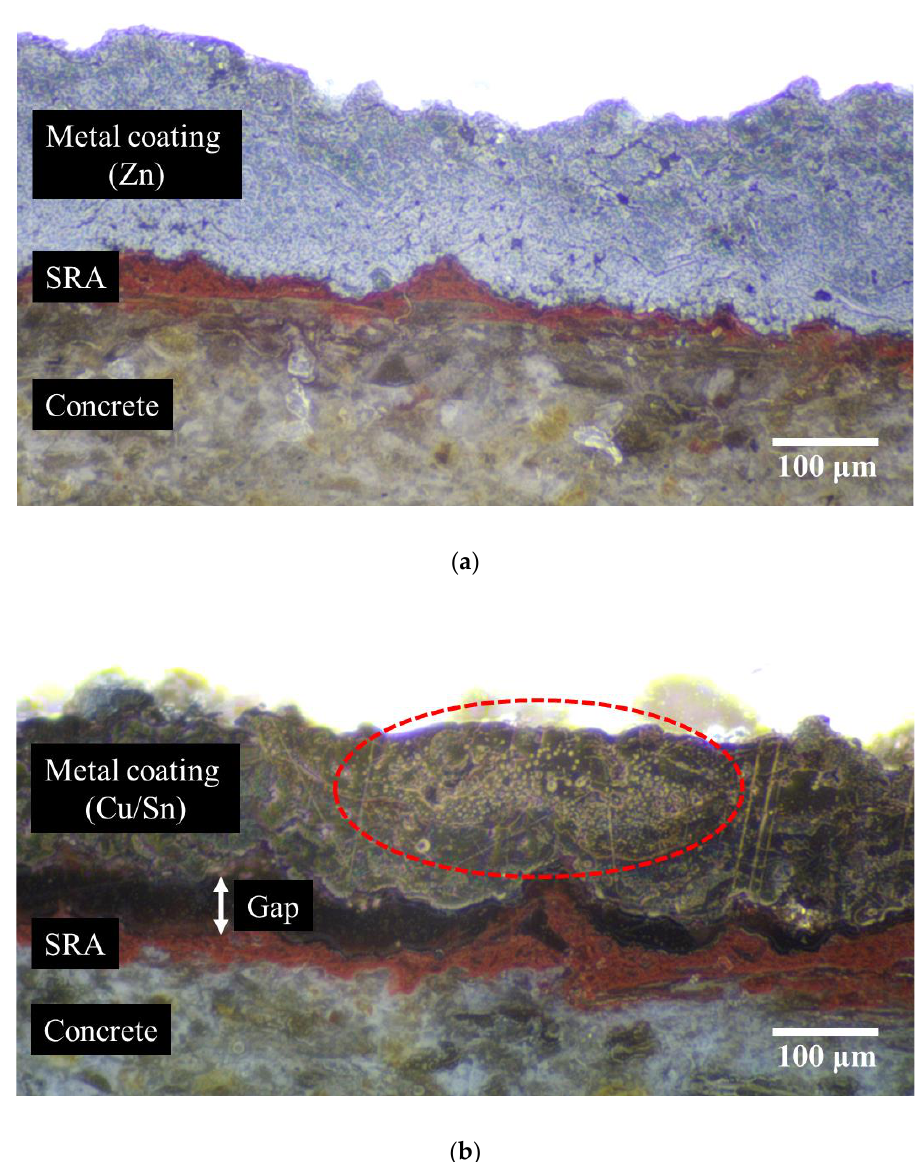
Figure 15. Cross-sectional areas of specimens. ( a ) Zn; ( b ) Cu+Sn.